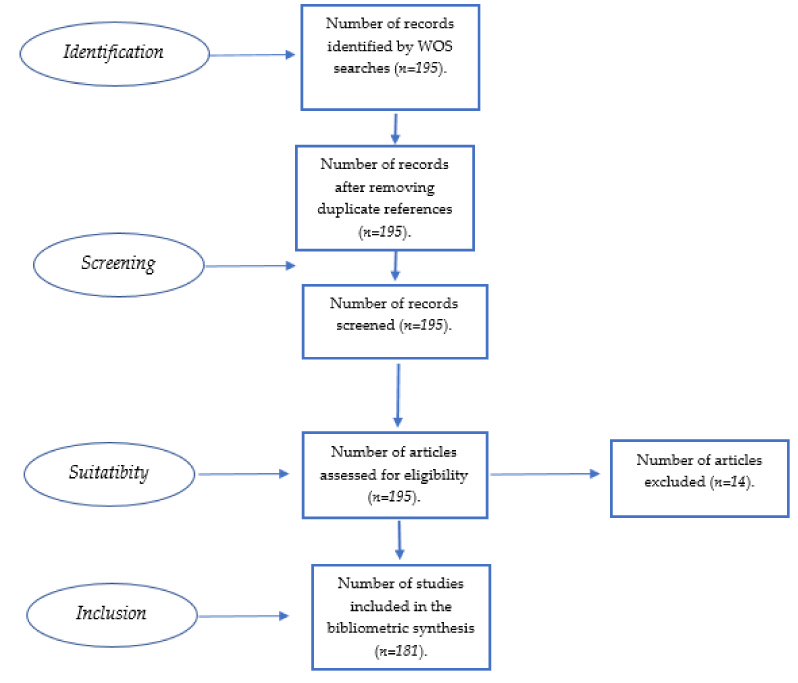
Figure 3. Prima flow diagram